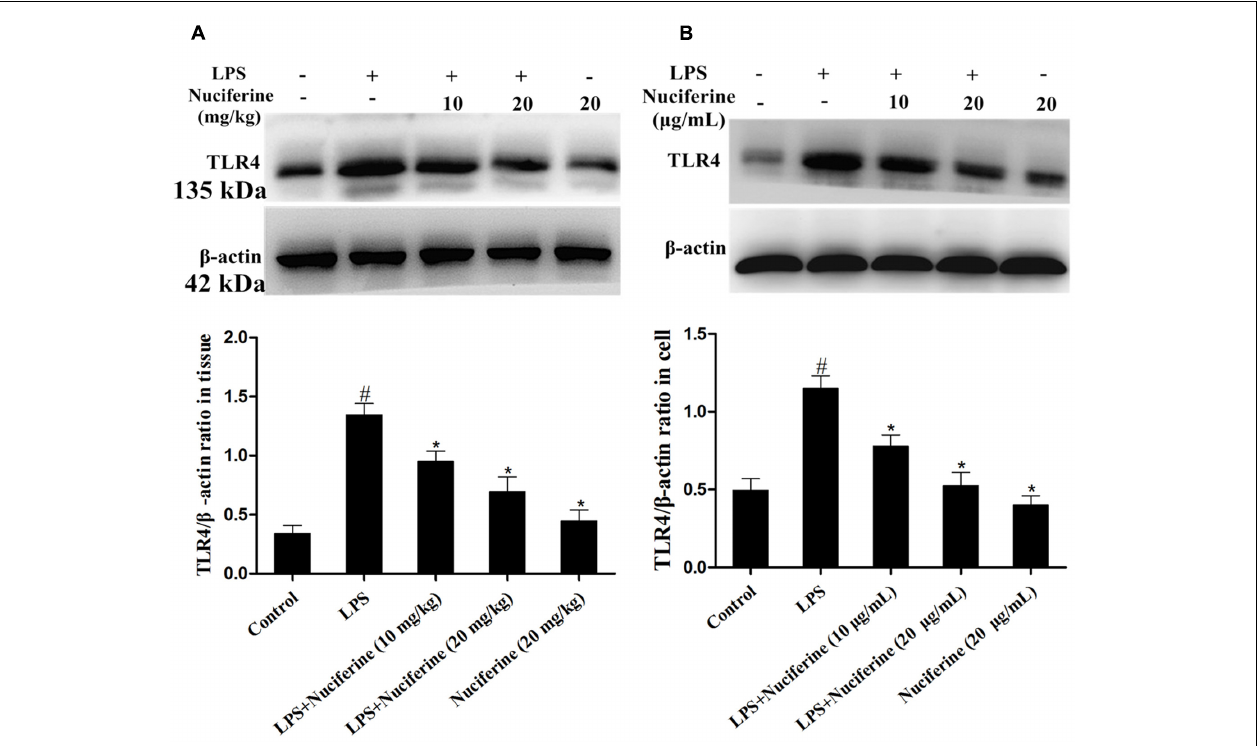
FIGURE 5 | Effects of nuciferine on the expression of TLR4. (A) The effects of nuciferine on TLR4 expression was determined by Western blotting in lung tissues. (B) The effects of nuciferine on TLR4 expression was determined by Western blotting in RAW264.7 cells. β -actin served as the control. Data are represented as the mean ± SEM of three independent experiments. # p < 0.05 vs. Control group, ∗ p < 0.05 vs. LPS